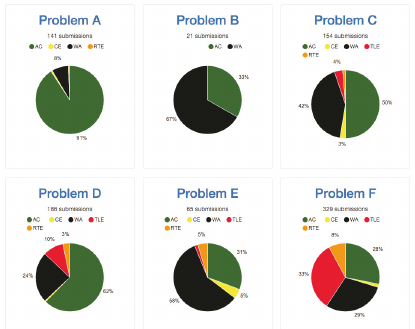
Figure 15: Code analytics